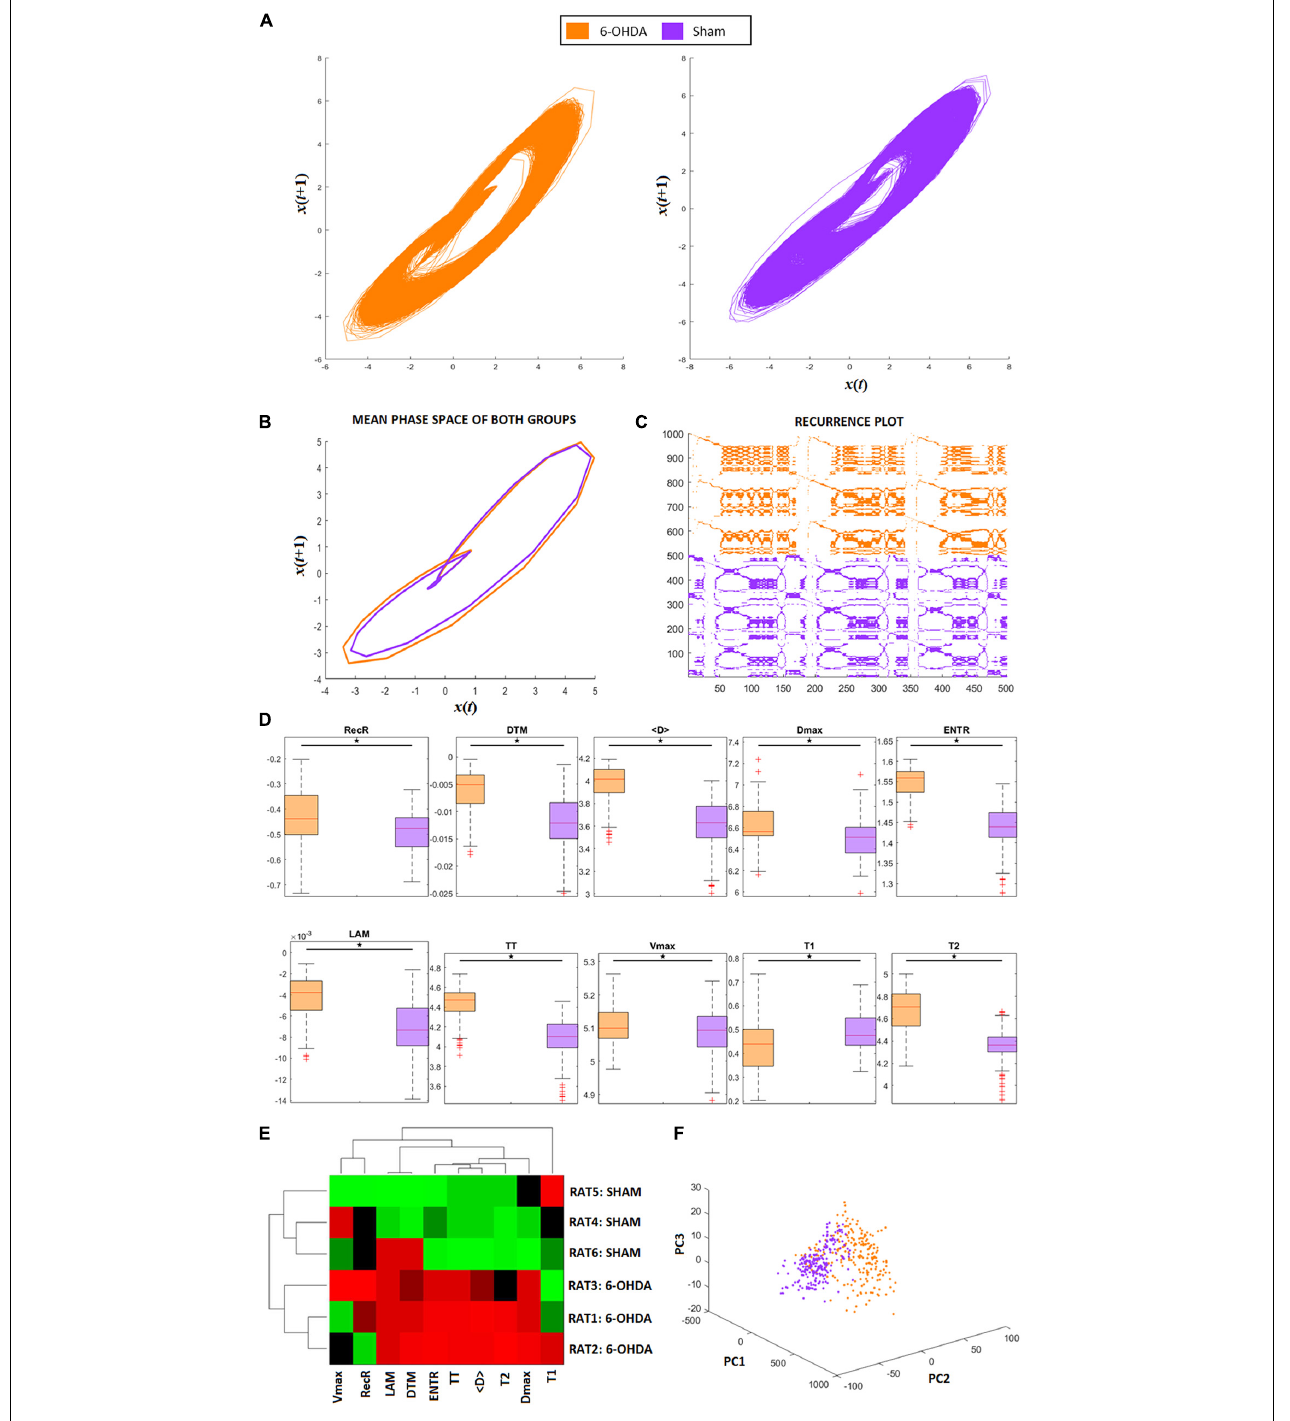
FIGURE 2 | RQA from animal model ECG recordings. (A) Phase space trajectories of ECG signals. (B) Phase-space mean trajectories related to both groups. (C) RP from the ECG signals of both groups. The 6-hydroxydopamine (6-OHDA) signals are more recurrent than ECG from the sham group. (D) Statistical comparison between each RQA factor from 6-OHDA and sham groups. All factors are revealed to be statistically different (exhibited in logarithm scale). (E) Clustergram of RQA factors using Euclidian distance as the metric of similarity. Each group presents its own set of RQA coefficient, forming two different clusters, 6-OHDA are rats 1–3, and sham are rats 4–6. In this case, Time type 2 (T2), Shannon entropy (ENTR), Trapping Time (TT), mean diagonal length ( < D > ), and maximum diagonal length (Dmax) are the main coefficients to distinguish one group from the other. (F) Principal Component Analysis from RQA factors also reveal that both groups differ from each other, with two distinct clusters with minimal overlap between